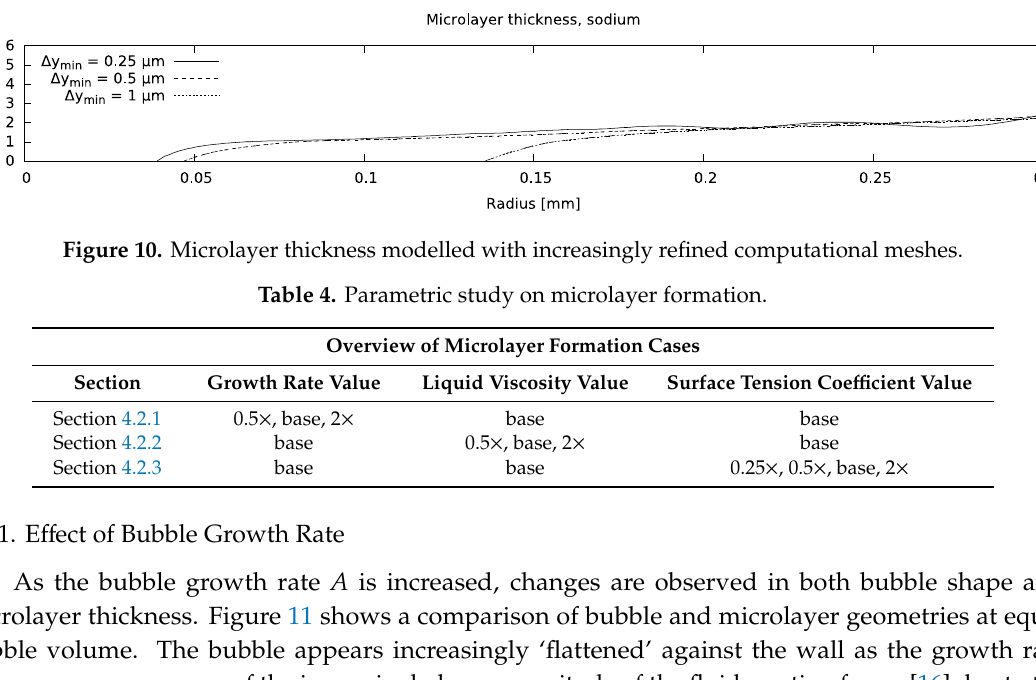
Table 3. Parameters relevant to microlayer formation: base case parameters.